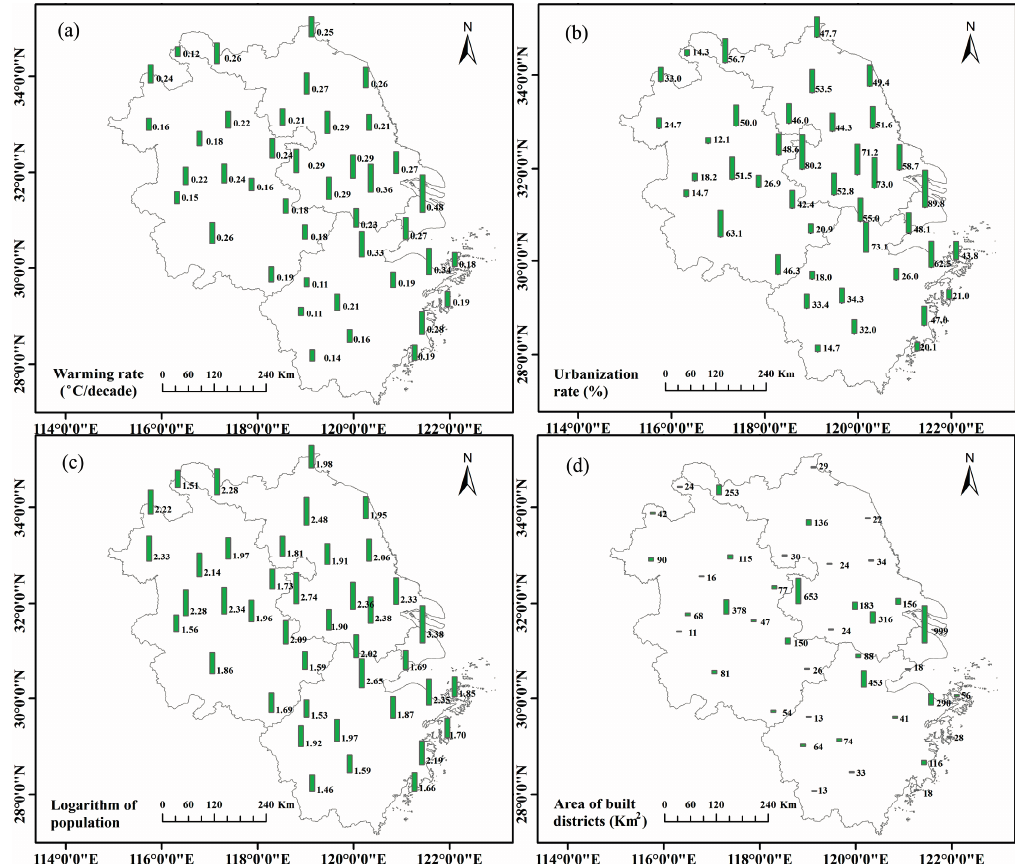
Figure 3. Spatial distribution of the warming rate of average air temperature ( a ), urbanization rate ( b ), logarithm of the population ( c ), and built-up areas ( d